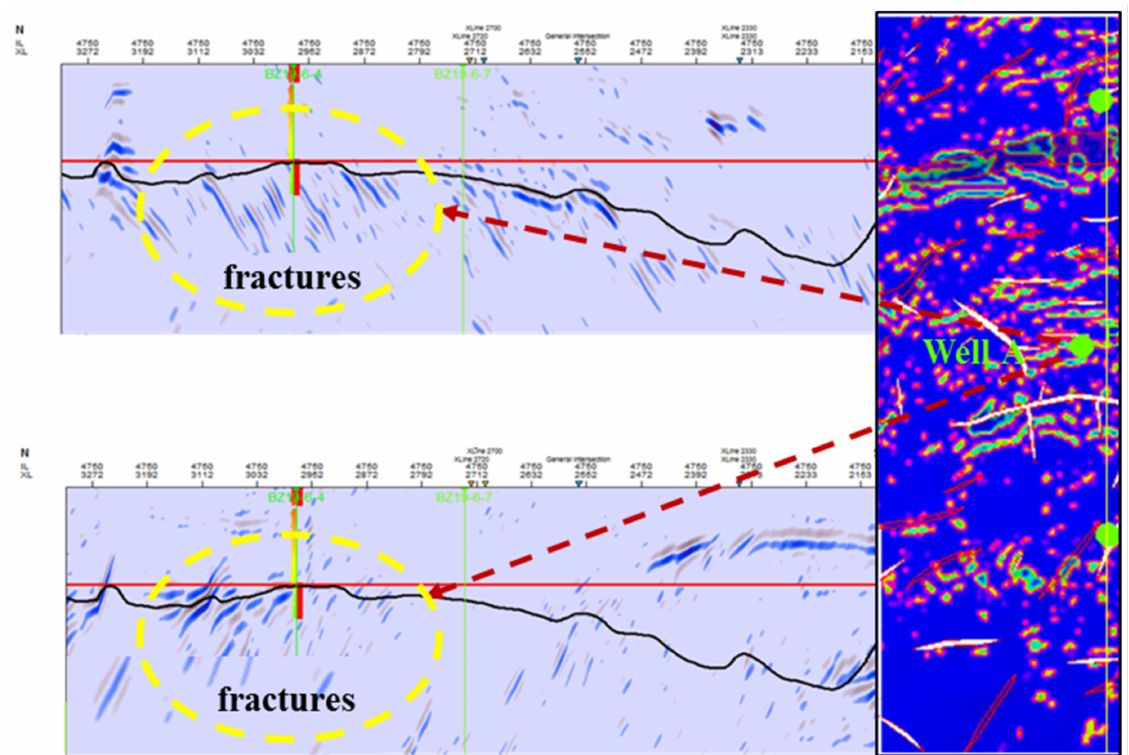
Figure 6. The tests show fractures in the formation.